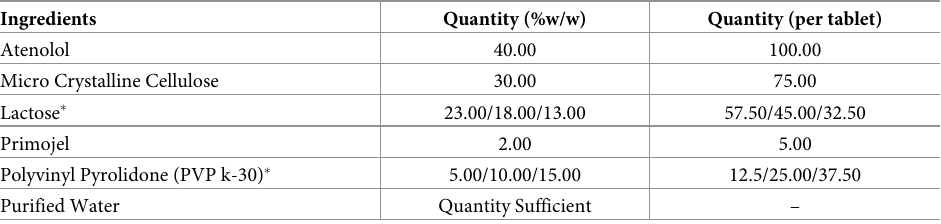
Table 1. Formulation of atenolol granules prepared by high shear wet granulation.